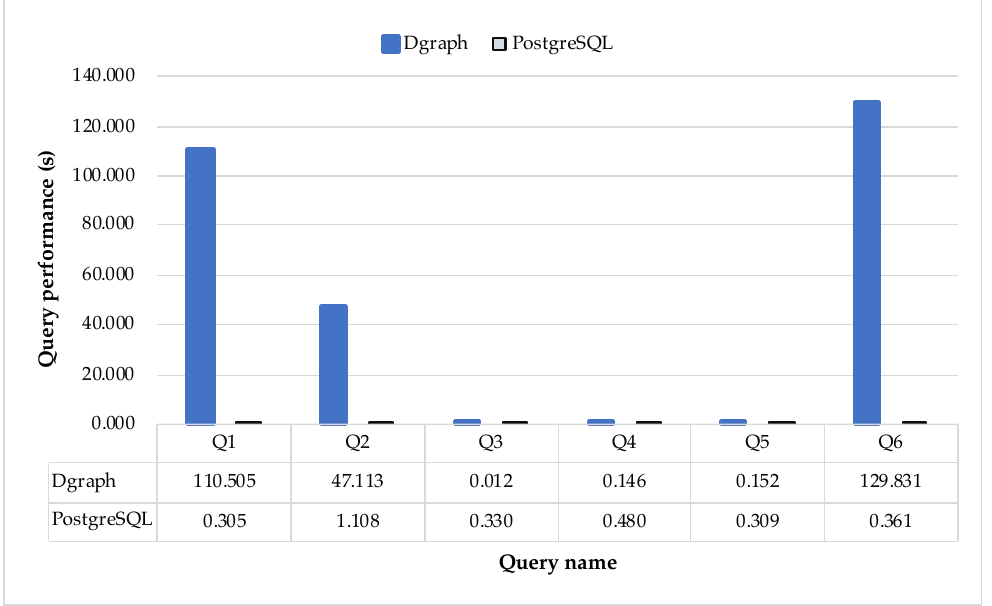
Figure 13. Query performance comparison between Postgres and Dgraph databases for IMDB